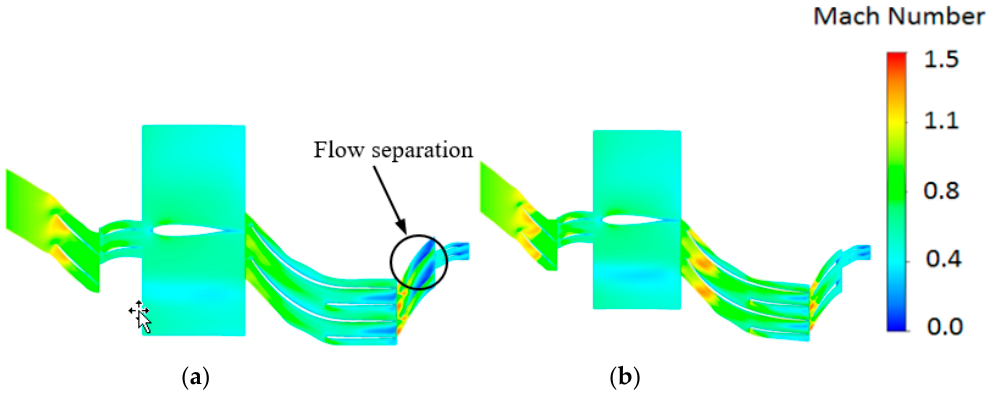
Figure 14. Design point Mach number distribution (50% blade span): ( a ) baseline; ( b ) optimized.